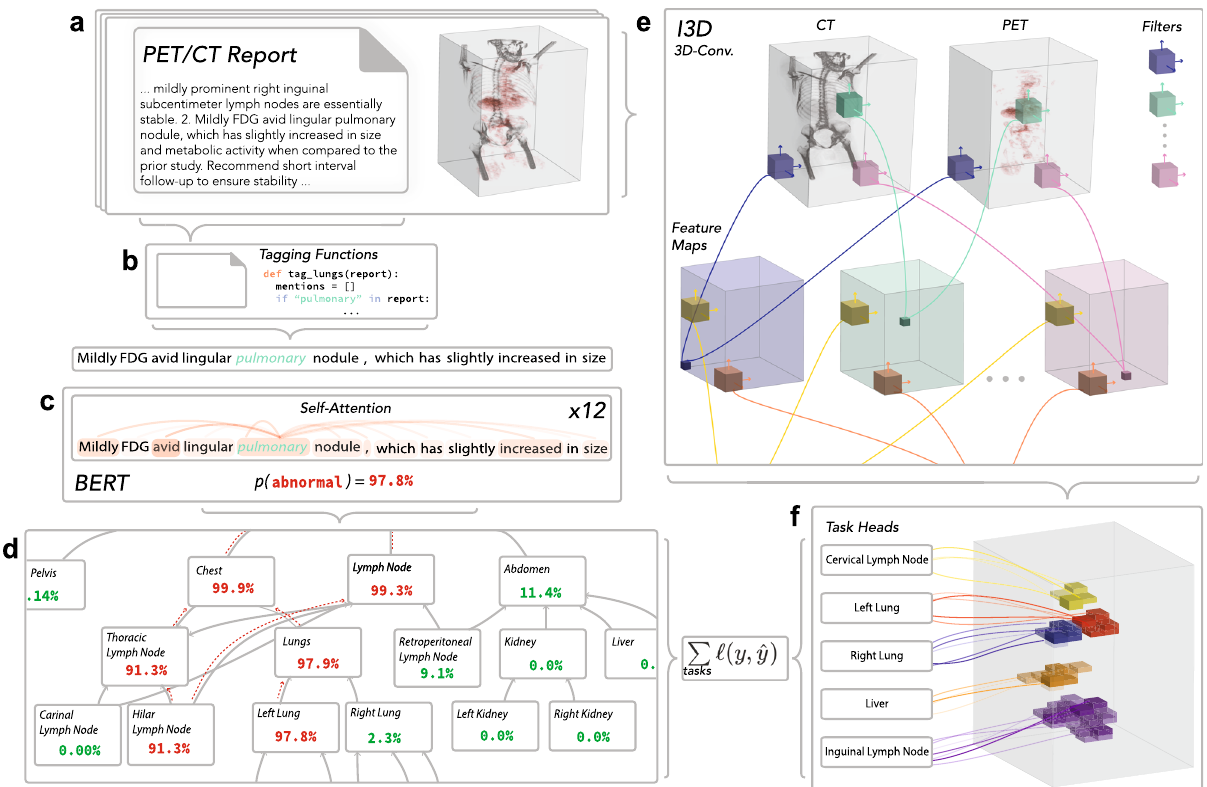
Fig. 1 Weak supervision, multi-task learning, and spatial attention are combined to build convolutional neural networks (CNNs) for FDG-PET/CT analysis without hand-labeled training data. a Our data set of 8144 FDG-PET/CT examinations. Each exam consists of (1) a 3D scan consisting of approximately 250 FDG-PET and CT slices and (2) a natural language, unstructured report written by the interpreting radiologist at the time of the study. Critically, there are no structured, ground truth labels for metabolic abnormalities in each anatomical region. b Tagging functions powered by regular expressions extract sentences that mention anatomical regions. c A language model predicts whether there is a metabolic abnormality in the tagged anatomical region. d Con fl icting language model predictions are reconciled into one probability of abnormality for each region. This is done by propagating probabilities up the directed-acyclic graph of the ontology. e The entire whole-body PET/CT scan is encoded using a 3D-convolutional neural network. This encoding process produces a three-dimensional representation of the original scan. f Each task head uses an attention module to extract from the encoded scan the voxels most relevant to the anatomical region it is charged with. We apply a fi nal linear classi fi cation layer to the weighted sum of those voxels to make a fi nal binary prediction for each region. To train the scan model, we minimize the cross-entropy loss between the report model predictions (left) and the scan model predictions